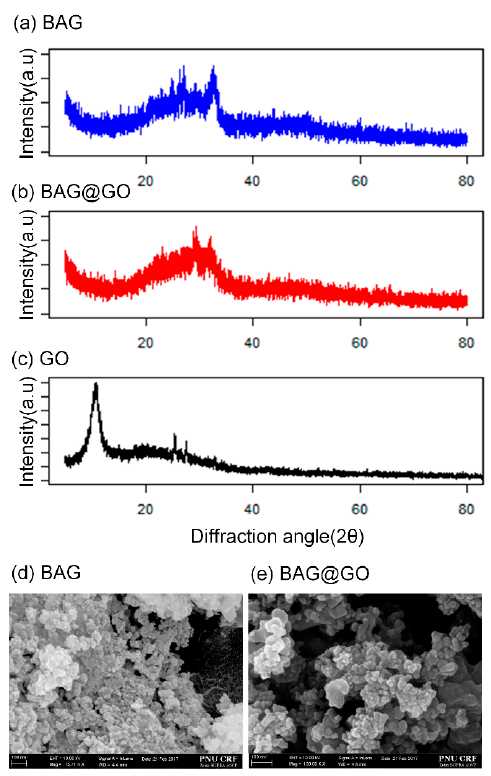
Figure 2. Characterization of BAG, BAG@GO and GO. ( a ) XRD of BAG; ( b ) XRD of BAG@GO; ( c ) XRD of GO; ( d ) SEM of BAG; and ( e ) SEM of BAG@GO.